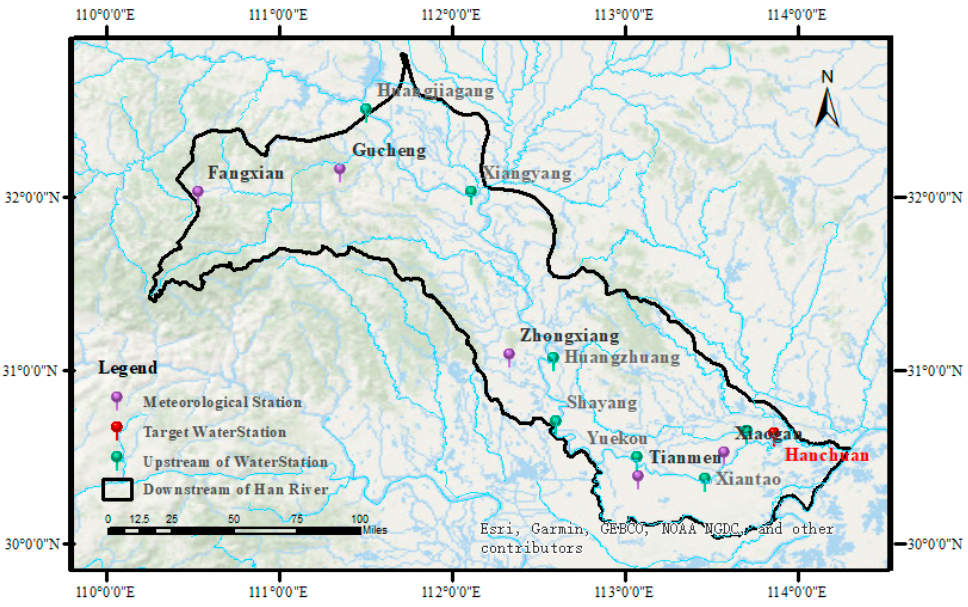
Figure 1. The location of meteorological stations and water-level stations in the Han River basin. Table 1. The information of the used data sets.